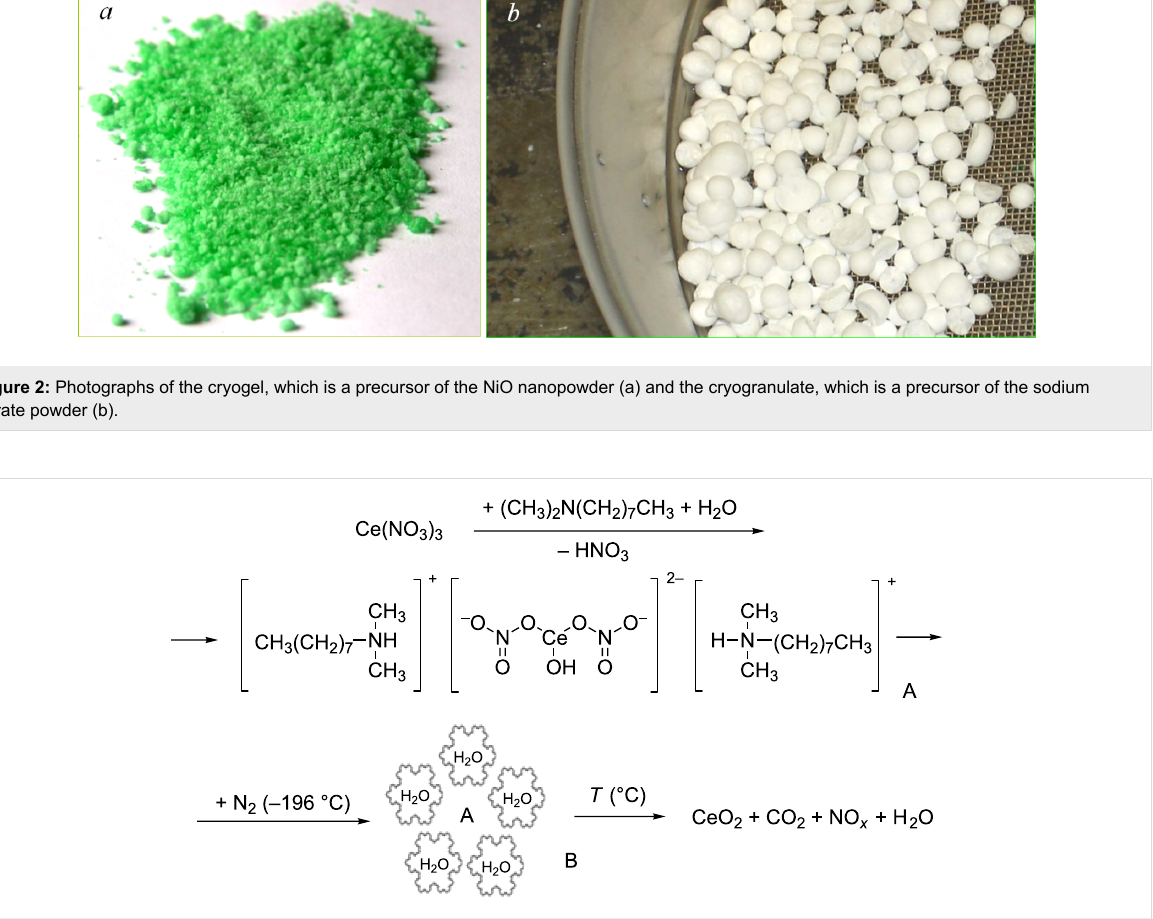
Scheme 1: Scheme describing the formation of crystalline metal oxides with water, carbon dioxide, and NO x as byproducts. Me n + – metal ions; NO 3 − – metal source, ligand; BWM – bound water